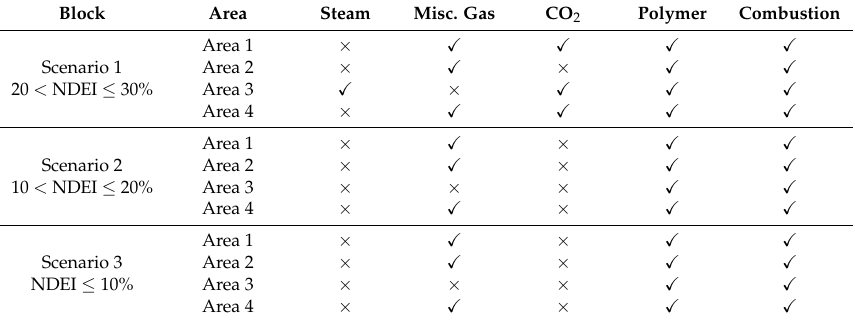
Table 6. Simulation results from NF model with the least root mean square error (RMSE) and non-dimensional error index